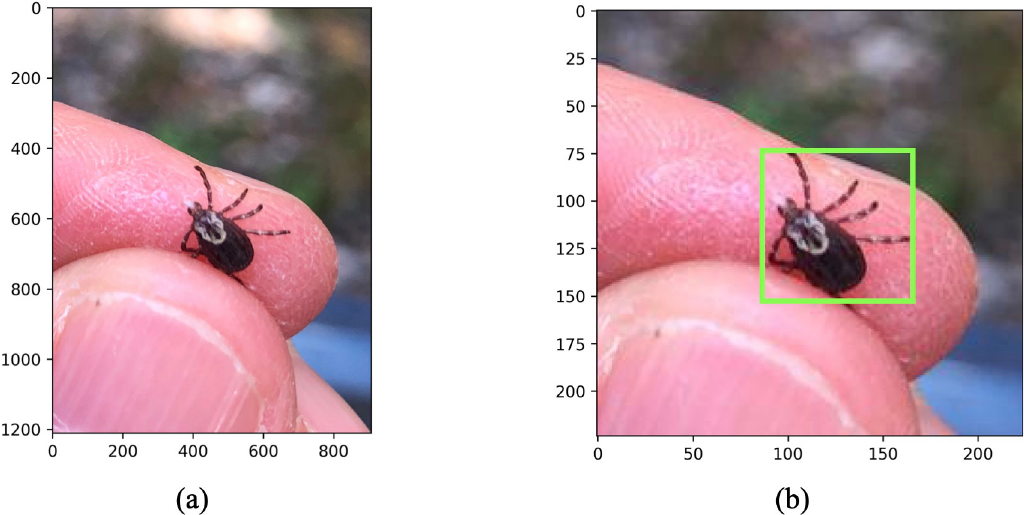
Fig 2. Cropping, resizing, and measuring the relative tick size (RTS) for user-generated images. (a) Original resolution image of a female Dermacentor variabilis tick. (b) The cropped and resized image (224x224 pixels) with the relative tick size bounding box depicted in green (RTS = 67 pixels).